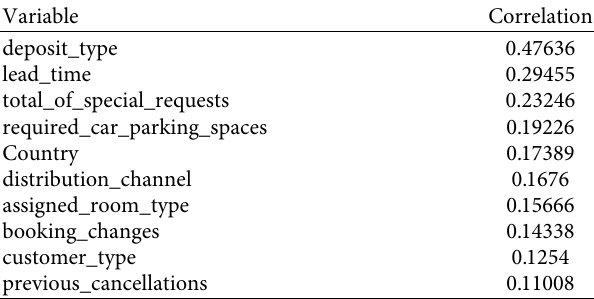
Table 1: Correlation with